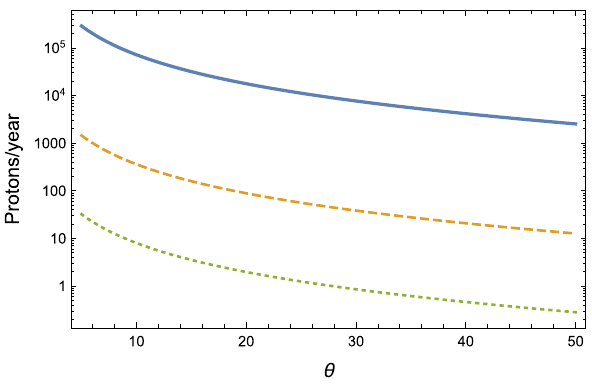
Fig. 5 We show the average number of protons scattered in one year from proton beams at an LHC luminosity of 2 10 34 cm − 2 s − 1 by a monopole–anti-monopole separating at velocity β = 0 . 01 as a function of scattering angle for the geometry that maximises the cross section and a maximum d ∼ 240 fm. The curves have been calculated for three monopole masses: 500 (solid), 1000 (dashed), 1500 (dotted)